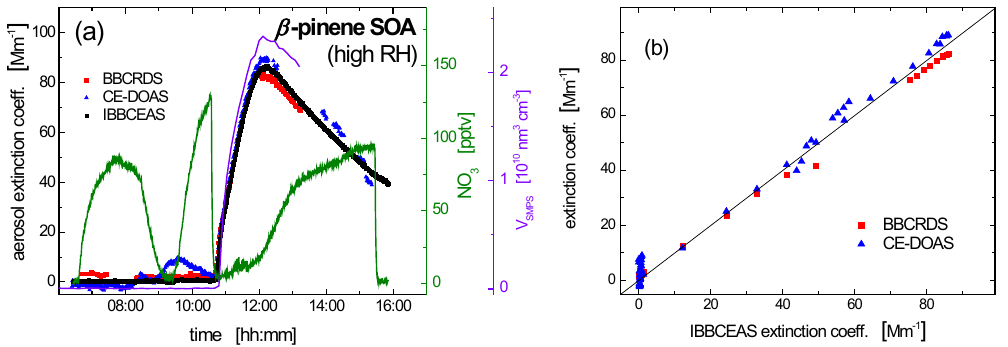
Fig. 4. (a) Time profile of the aerosol extinction coefficients following NO 3 oxidation of β -pinene under humid conditions (21 June). Changes to the chamber composition occurred at 06:23–06:30 (160ppbv O 3 ), 06:35 (1ppbv NO 2 ), 08:26 (flushed chamber to 60% RH), 09:24–09:34 (80ppbv NO 2 ), 09:36 (90ppbv O 3 ), and 10:34 (15ppbv β -pinene). The NO 3 concentration (green) and aerosol volume (violet) are also shown. (b) correlation plots of the aerosol extinction coefficients retrieved by the BBCRDS and CE-DOAS instruments against those from the IBBCEAS measurements. The 1:1 line is shown as a solid